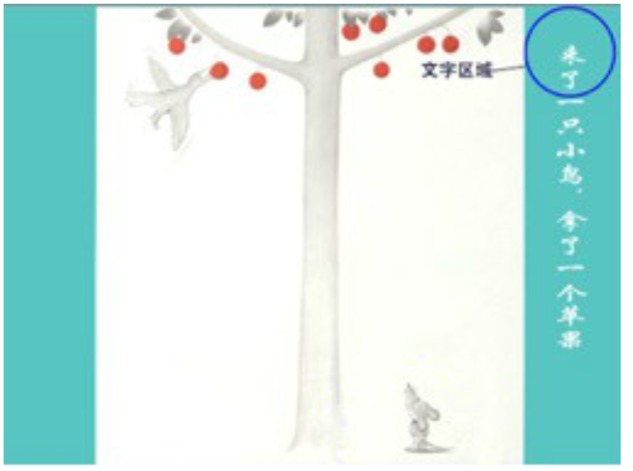
Sample page from the picture book with words (the blue circle did not appear on the actual page).